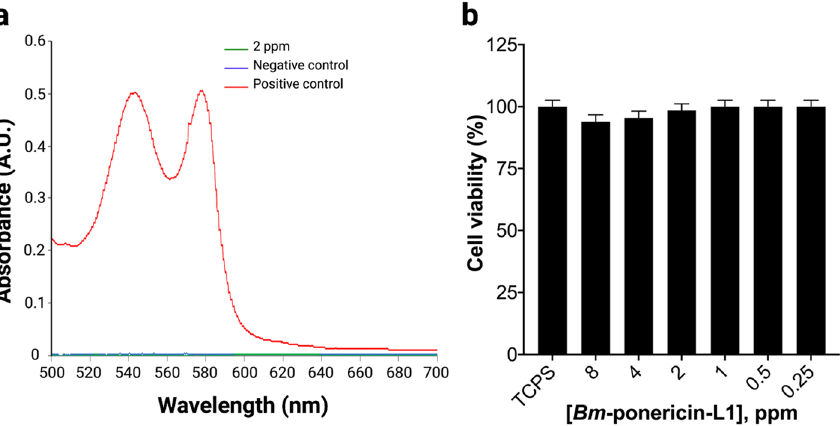
Figure 10. Hemocompatibility and cytocompatibility assay of the purified Bm -ponericin-L1 from infected B. mori larvae on erythrocytes ( a ) and primary fibroblast cell lines (ATCC PCS-201-012) ( b ) respectively. The data were expressed as mean ± standard deviation and the significance level was set at p <